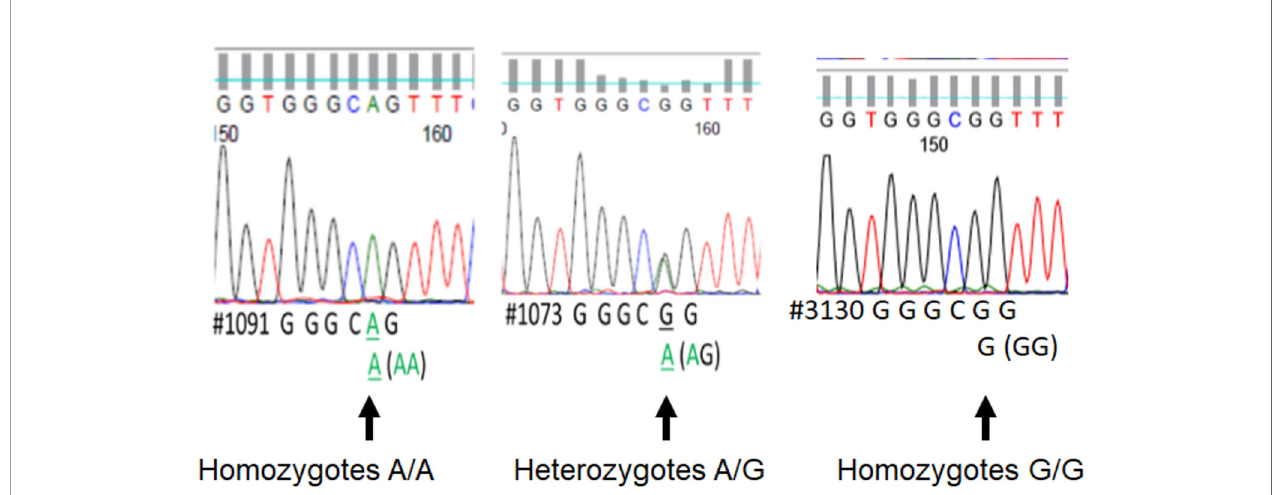
FIGURE 1 | The printout of Sanger sequencing of rs867186 allele from an automated sequencer. The sequence is represented by a series of peaks, one for each nucleotide, a green peak is an “ A, ” blue is “ C, ” black is “ G, ” and red is “ T. ” It shows the representative image of homozygotes with two copies A (full peak, left), heterozygotes with one copy G/one copy A (half peak, middle), and two copies G (full peak, right), respectively.